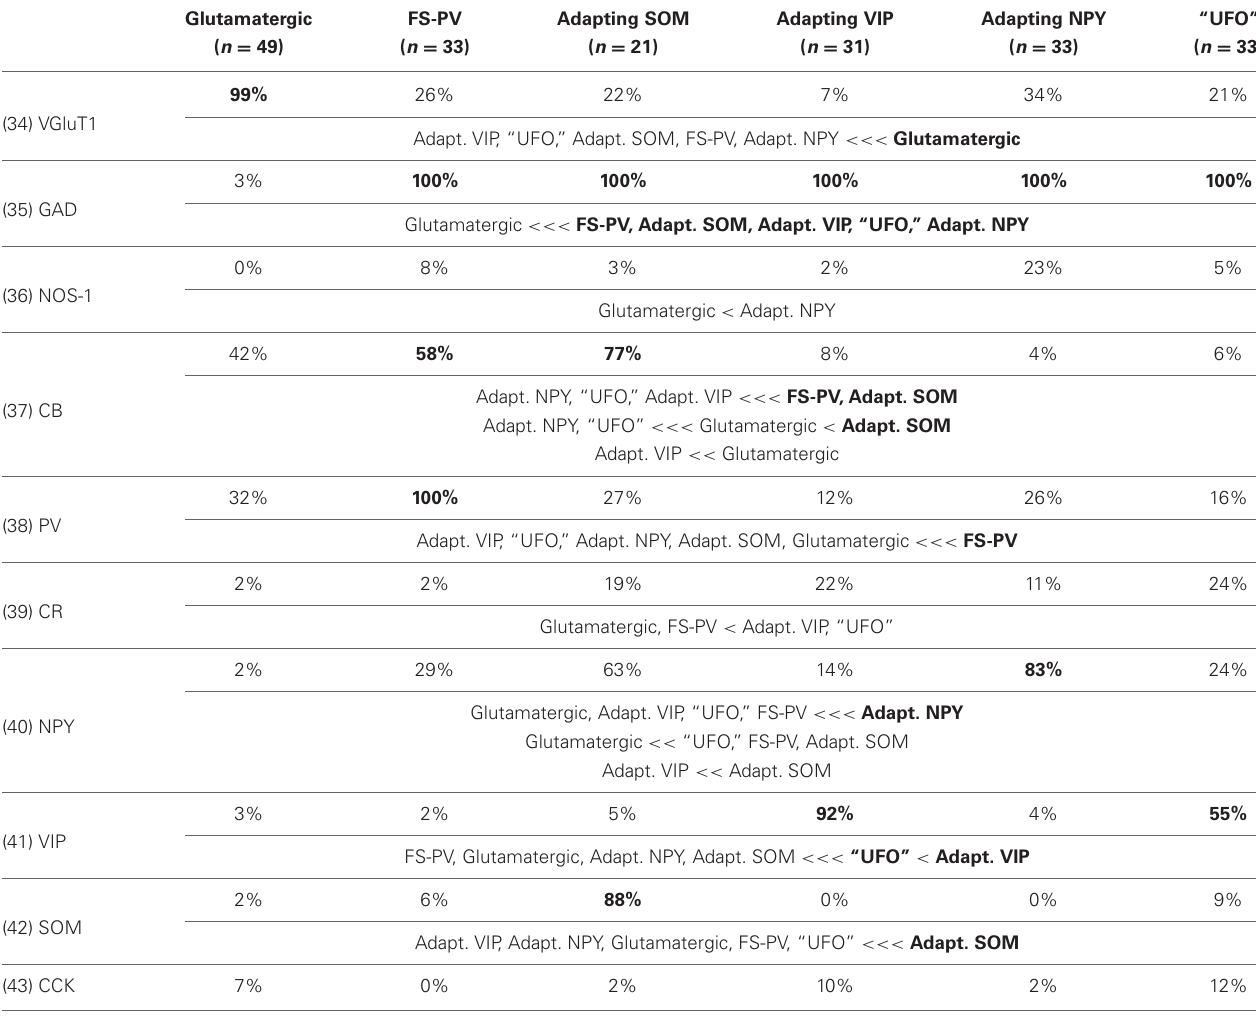
Table 4 | Occurrence of molecular markers in different archetypes. Glutamatergic FS-PV Adapting SOM Adapting VIP Adapting NPY